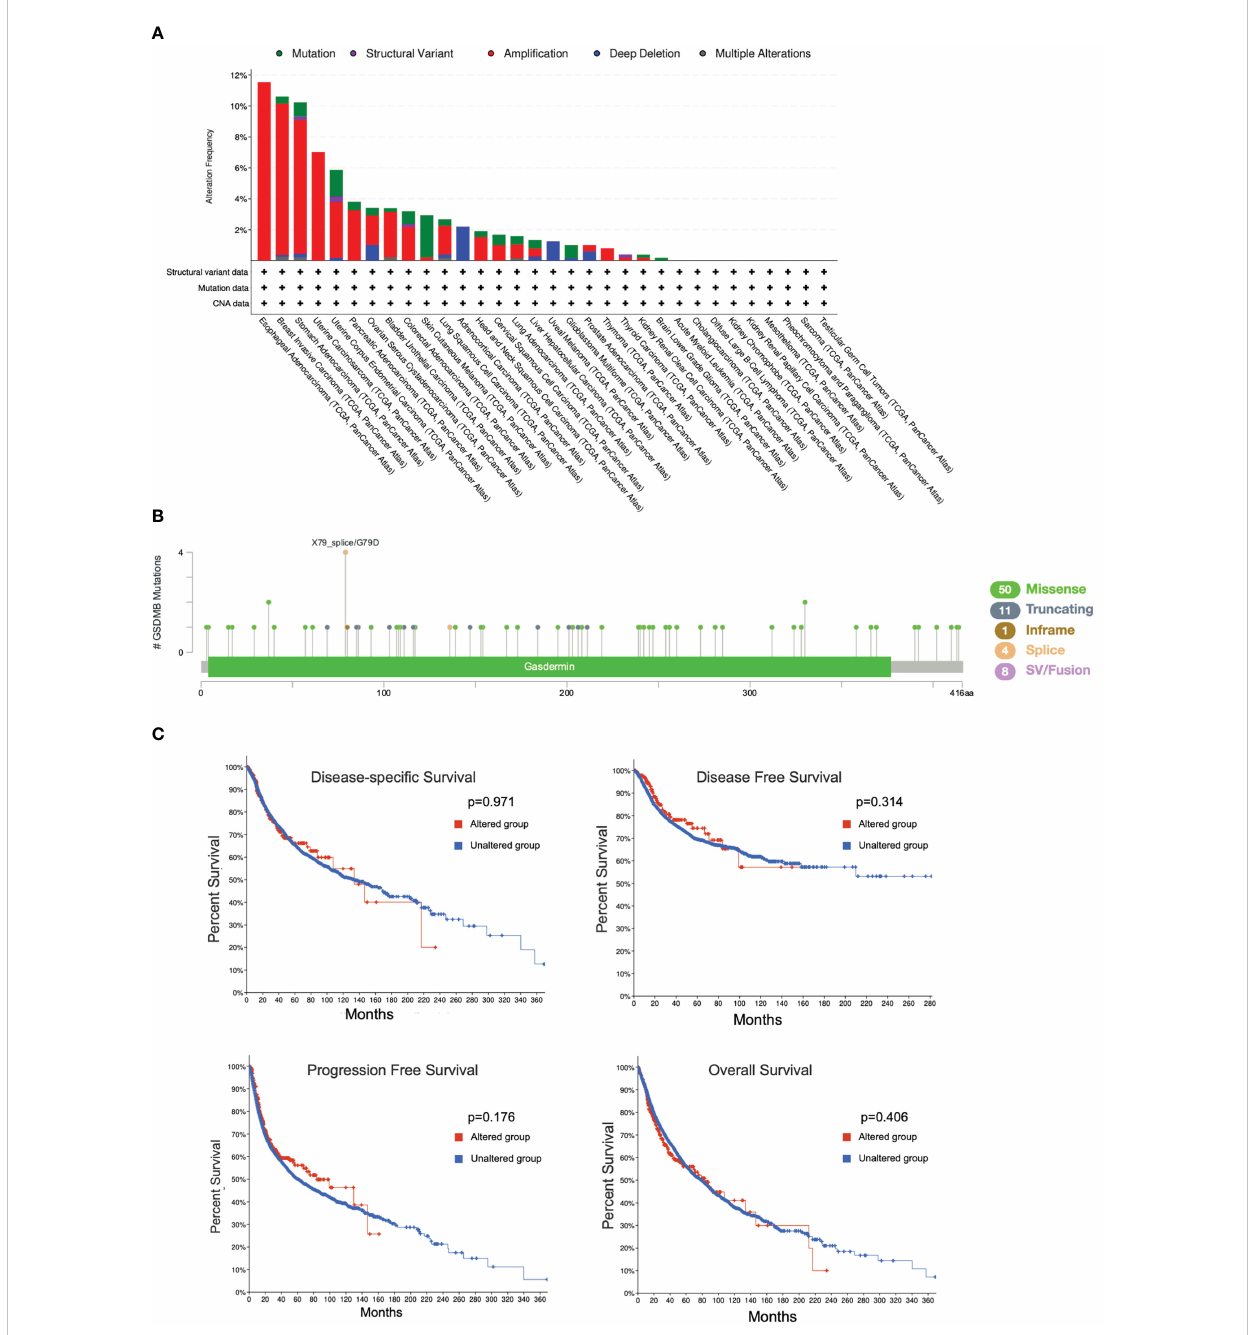
FIGURE 7 Mutation features of GSDMB in different cancers in TCGA. The alteration frequencies with mutation type (A) and mutation site (B) are shown. Each color denotes a mutation type. Mutation (green): point mutation. (C) The potential correlation between the mutation status of GSDMB and overall survival, disease-free survival, progression-free survival, and disease-speci fi c survival of different tumors using the cBioPortal tool. GSDMB, gasdermin B; TCGA, The Cancer Genome